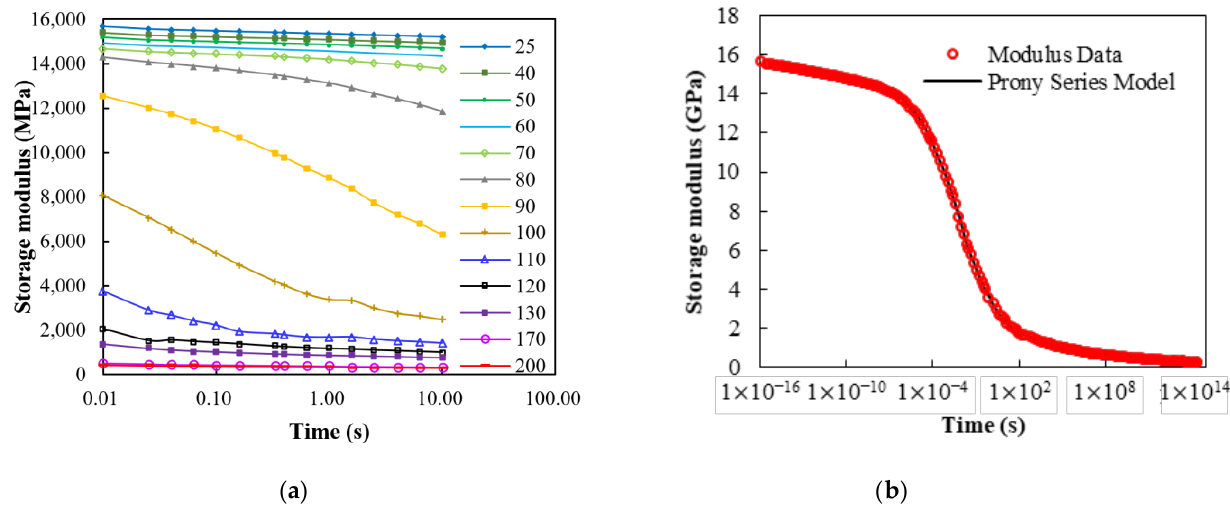
Figure 8. ( a ) Stress relaxation storage moduli at different isothermal temperatures; ( b ) Construction of single master curve and its Prony series representation.